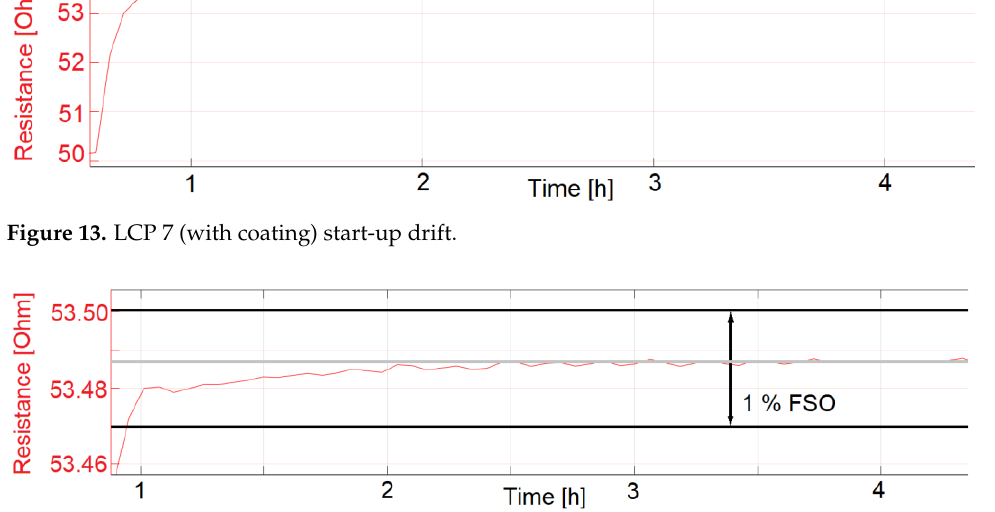
Figure 15. LCP 1 (with coating) start-up drift, zoomed to 1% FSO. The start-up drift was only calculated for the sensors presented in Figures 13 – 15. Sen- sors with identical manufacturing parameters, but without a coating with fluoropolymer, did not show the desired start-up behavior. Instead, a drift in the electrical resistance could be observed for these sensors, shown in Figures 16 and 17. A drift of the electrical resistance was also observed for other tested sensors, such as LCP 6, COC 1, and COC 3. Figure 16. LCP 1 (without coating) start-up drift. Sensor signal drifts with ongoing exposure to 77.5 °C and 60% RH.